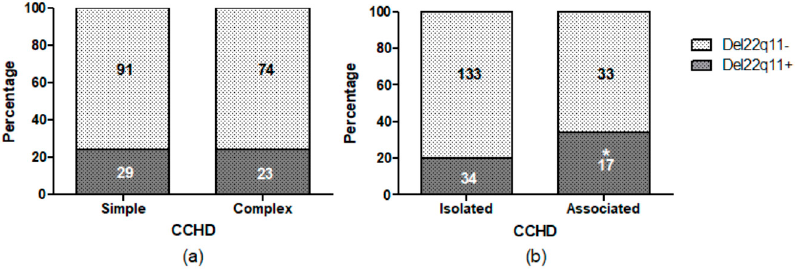
Figure 3. Distribution of the 22q11 deletion in simple or complex CCHD ( a ) or in CCHD presented as isolated or associated ( b ). Del 22q11 refers to the 3 Mb and 1.5 Mb deletions. CCHD: Conotruncal congenital heart defects. Inside the charts, numbers of patients in each category. * p < 0.05.